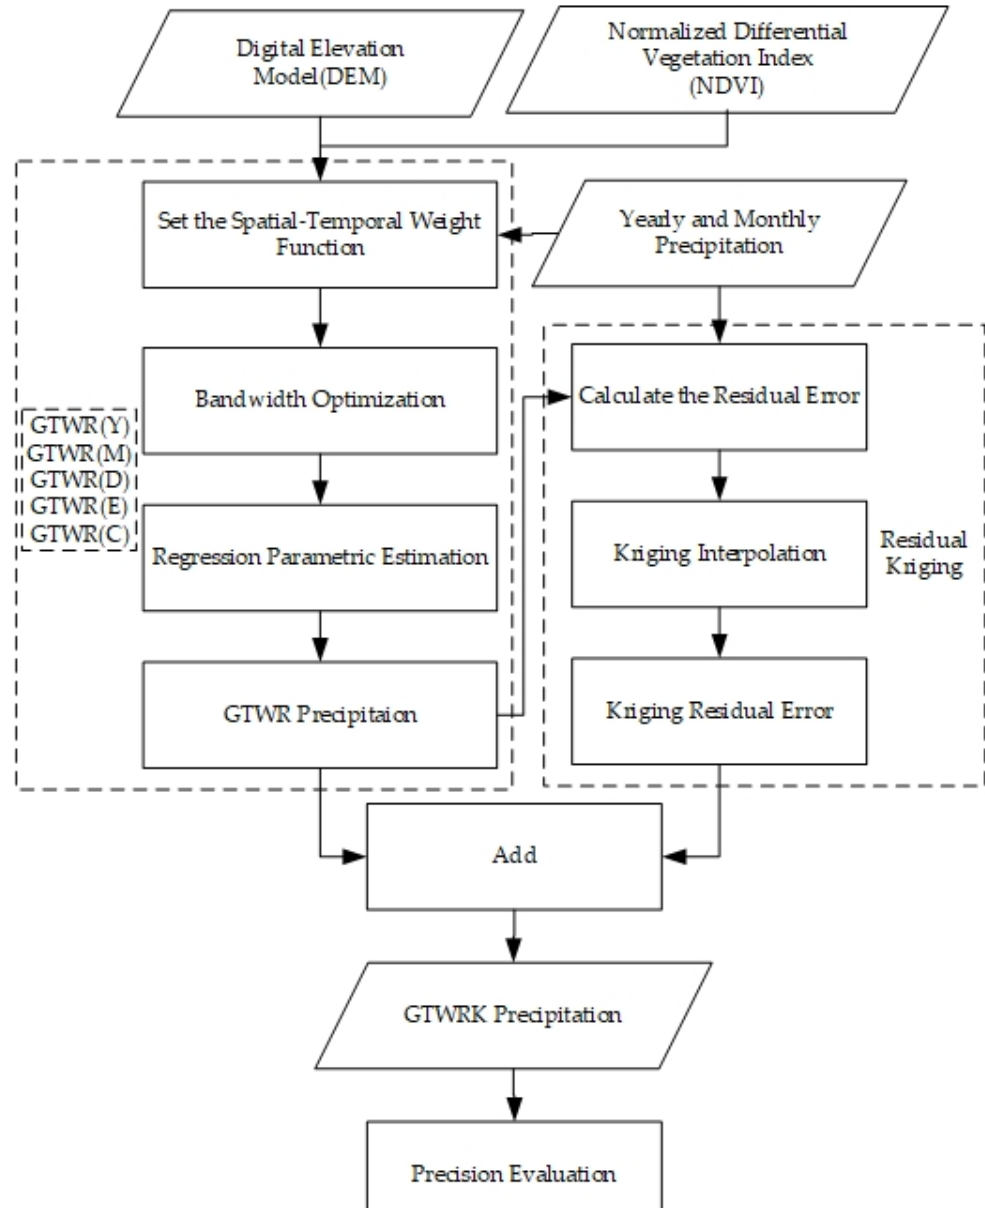
Figure Figure 1. The flow chart of the geographically and temporally weighted regression kriging (GTWRK) model.2.1.4. Precision Evaluation